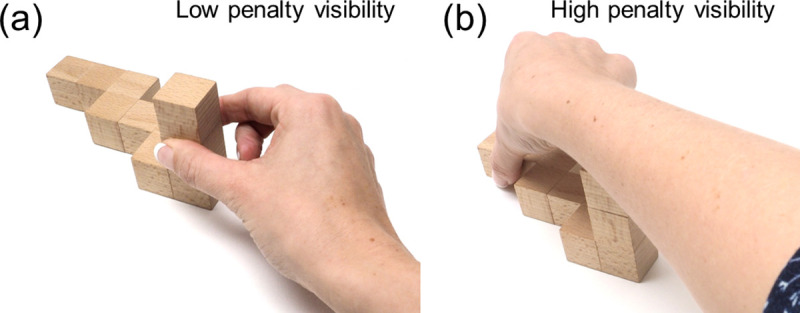
Optimal visibility.Examples of grasps with (a) low penalty and (b) high penalty visibility.